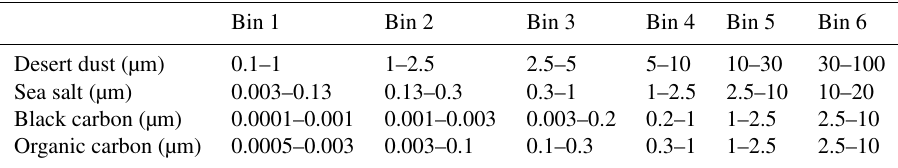
Table 1. Bin ranges of individual primary aerosol species present in